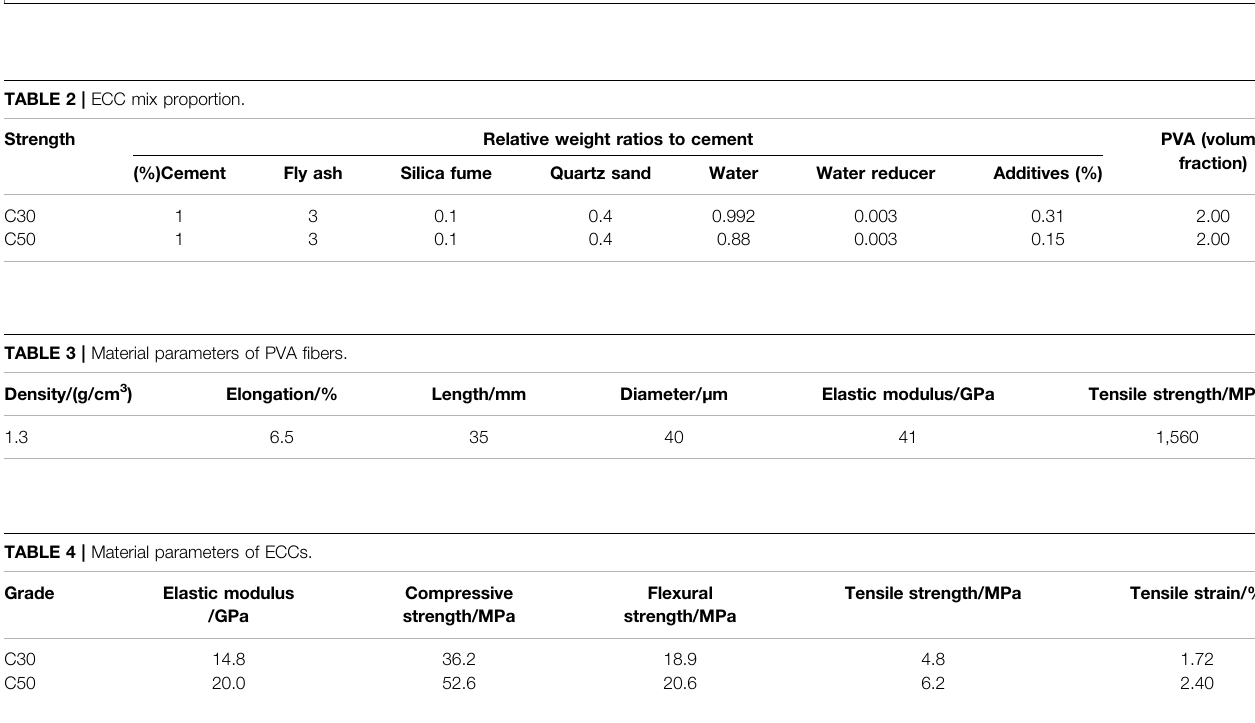
FIGURE 3 | Test setup and measurement layout for the composite beam.